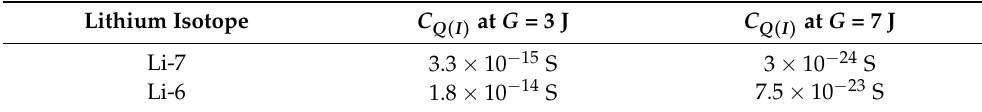
Table 9. The table shows that intracellular lithium isotopes can have a range of quantum conductance of single channel from the value at G = 3 J to the value at G = 7 J according to the setting values in graph (a) of Figure 5.